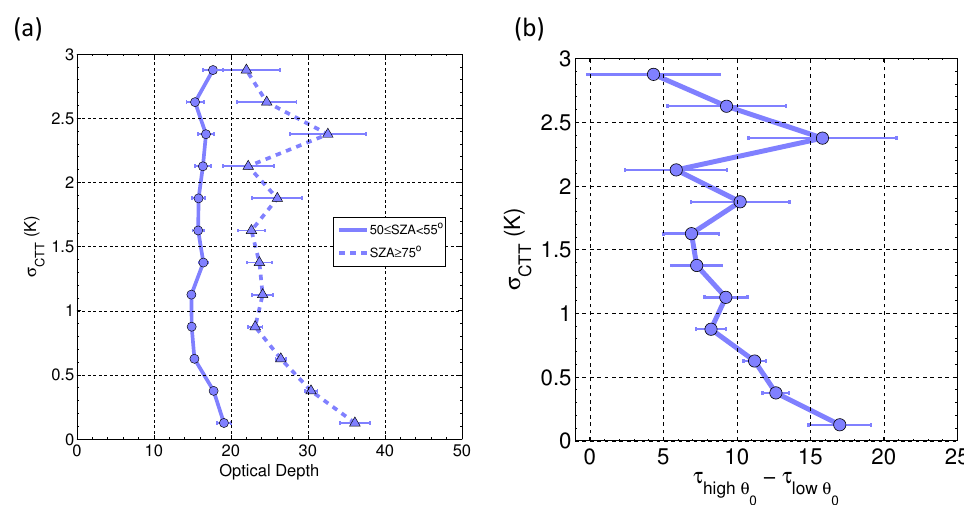
Figure 11. (a) Optical depth vs. σ CTT for low VZA ( ≤ 41 . 4) and for different solar zenith angles (SZA or θ 0 , see the legend). Other data restrictions are described in the text. (b) Differences in optical depth between high and low θ 0 .